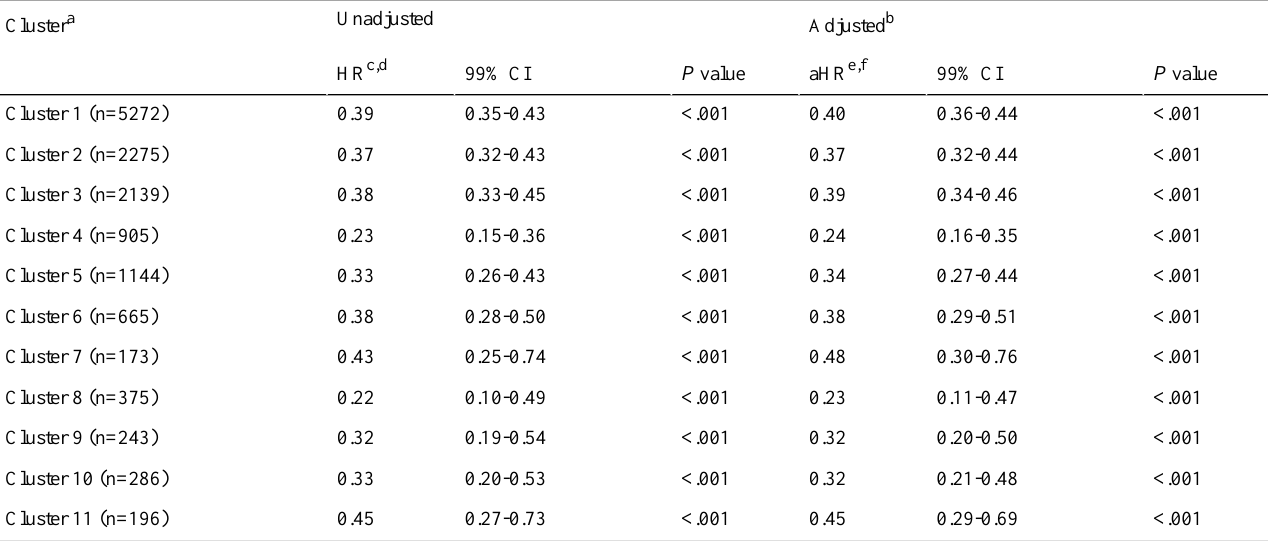
Table 3. Cox regressions for mortality and 1-year landmark analysis among Chinese herbal medicine and Western medicine